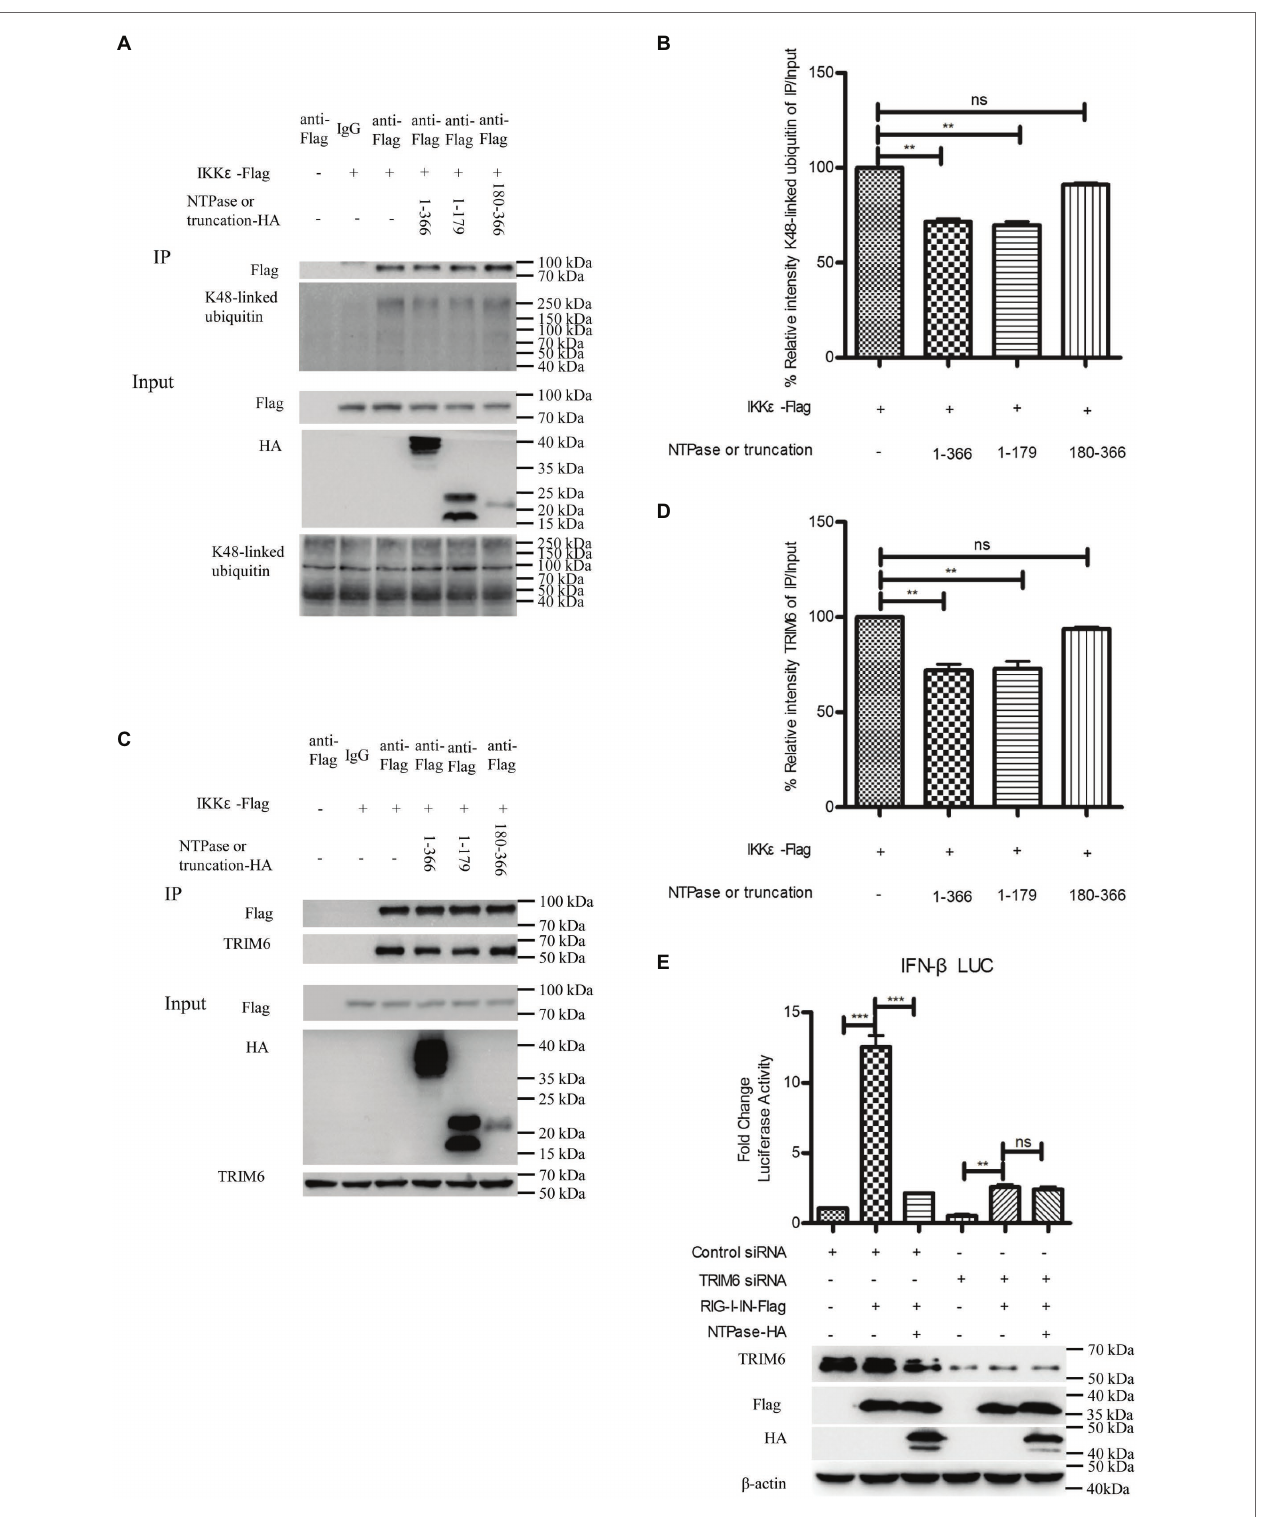
FIGURE 8 | HuNoV NTPase reduces the association of IKK ε with unanchored K48-linked polyubiquitin chains and tripartite motif-containing 6 (TRIM6). (A) HuNoV NTPase suppresses the interaction of IKK ε with K48-linked polyubiquitin chains. HEK 293T cells in 6-well plates were cotransfected with 1.5 μ g plasmid expressing HA-tagged NTPase or truncated NTPase together with 1.5 μ g Flag-tagged IKK ε expression plasmid or empty vector for 40 h. A mouse anti-Flag Ab was used